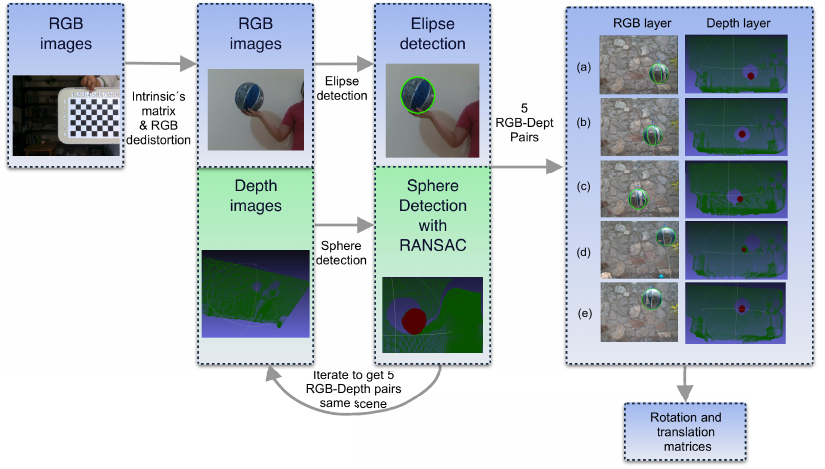
Figure 8. Proposed methodology. A minimun of five different pair images color-depth ( a – e ) are required to find ellipses and sphere